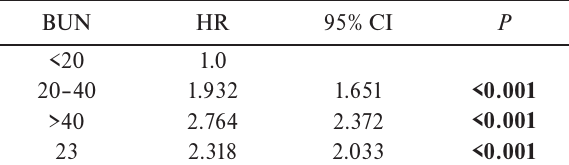
Table 5. Hazard ratios for eICU patients.